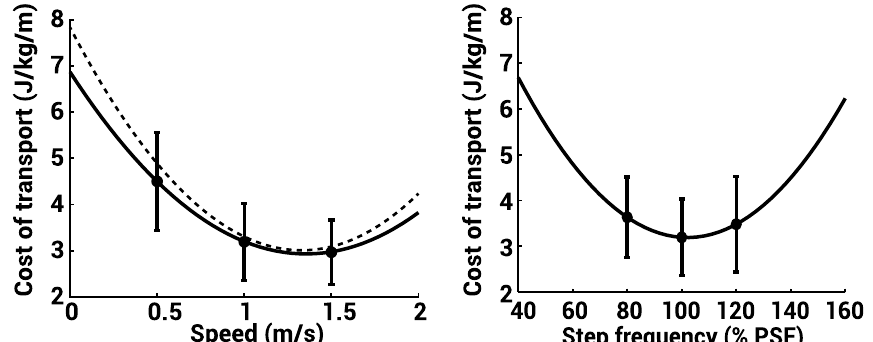
Figure 1. COT landscape curves with respect to walking speed (left) and step frequency (right). Data shown are means (filled circles) and standard deviations (error bars) (n = 10). The solid curves show a 2nd order polynimial fit of the mean data. The dashed curve shows the COT vs speed equation derived by Browning and Kram 2 .